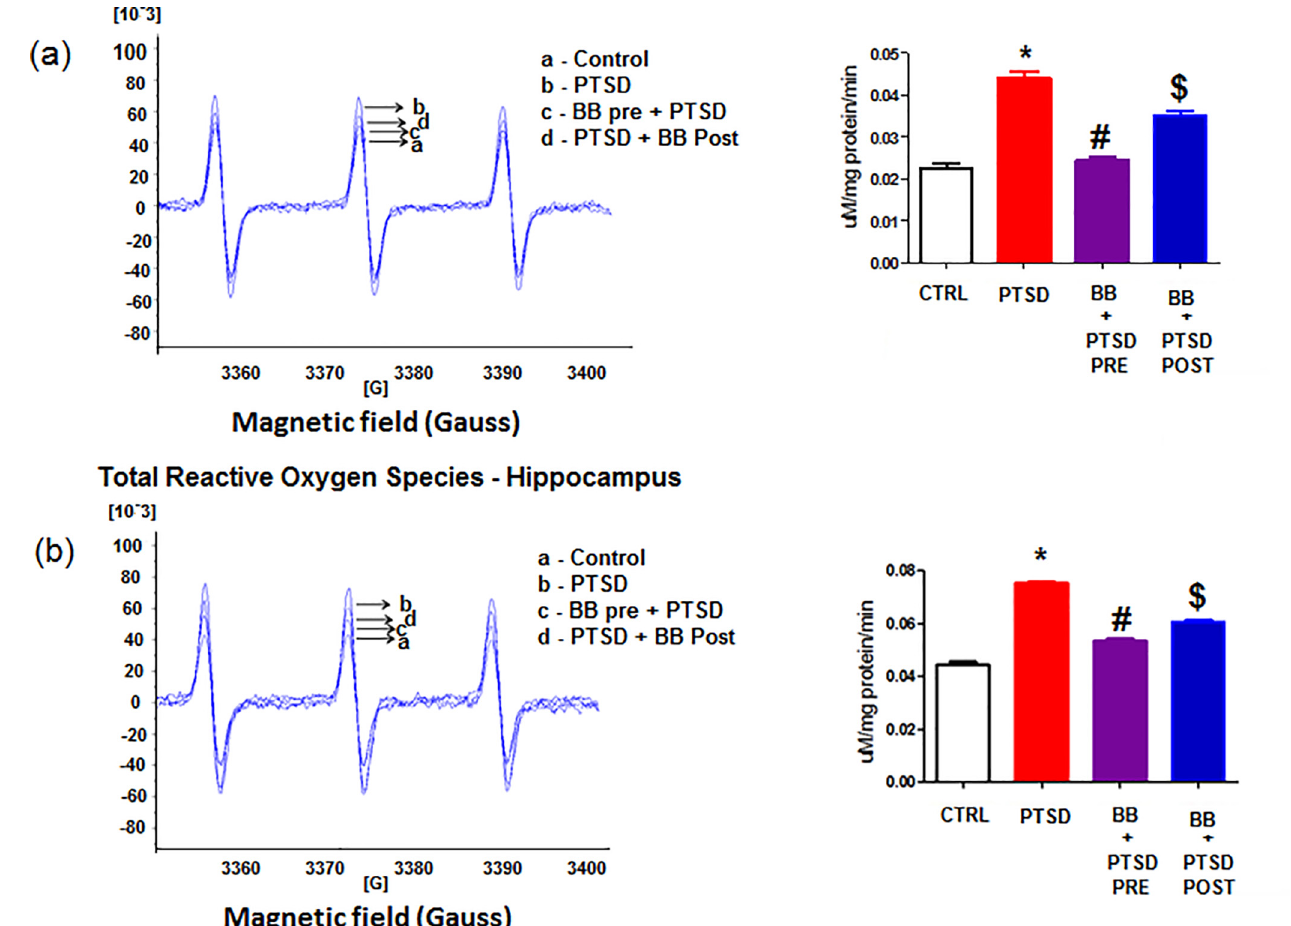
Fig 2. a and b: Reactive oxygen species in the prefrontal cortex and Hippocampus: The total reactive oxygen species were significantly elevated in the PTSD group. The elevation was normalized to control group levels with blueberry diet. Statistical analysis was performed using one way ANOVA with repeated measurements followed by Tukey ’ s multiple comparison test. * p < 0.05 Control Vs PTSD, #p < 0.05 PTSD Vs BB = PTSD, and $p < 0.05 PTSD Vs PTSD + BB. All data are presented as mean ± SEM. P < 0.05 compared to